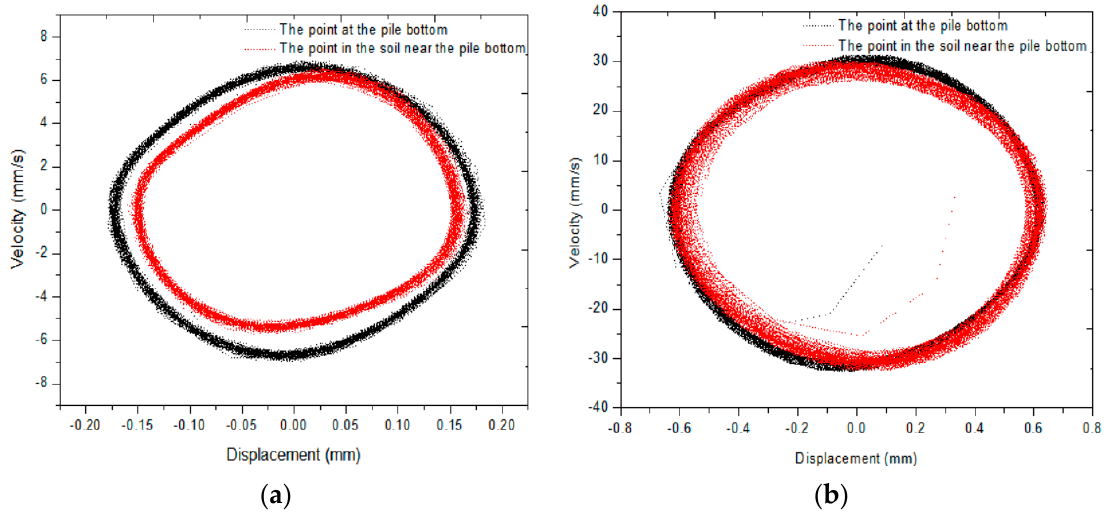
Figure 14. Phase-Plane Curves of “Adjacent” Measuring Points at Soil-Pile Interface under Sine Excitation: ( a ) S5-1, ( b ) S10.